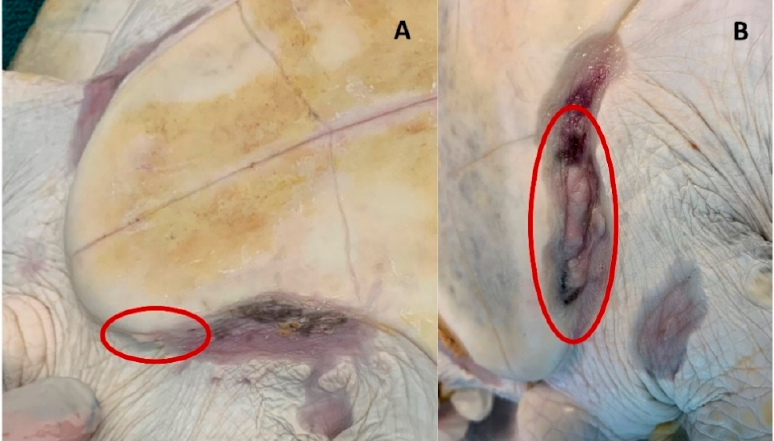
Figure 5. Representative images of regrowth of the left inguinal region of the plastron in two different individuals. ( A ) Represents regrowth of a VT+ UV+ individual 7 weeks post-surgery. ( B ) Represents regrowth of a VT+ UV − individual, 10 weeks post-surgery.